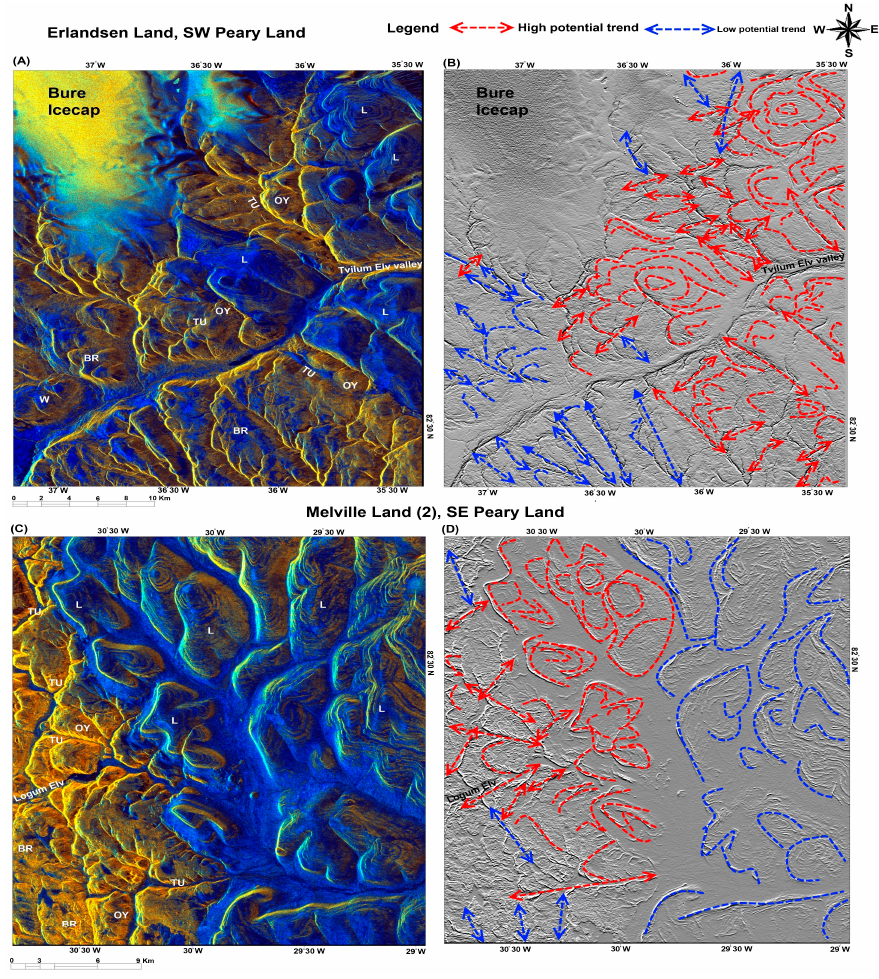
Figure 10. ( A ) FCC image map of PCA2, PCA3 and PCA5 for the PALSAR subset of the Erlandsen Land; ( B ) E–W (90°) directional filter image derived from PCA2 for the subset of the Erlandsen Land; ( C ) FCC image map of PCA2, PCA3 and PCA4 for the PALSAR subset of the Melville Land (2); ( D ) E–W (90°) directional filter image derived from PCA2 for the subset of the Melville Land (2). Referee to Figure 8 for lithostratigraphic unit abbreviations.